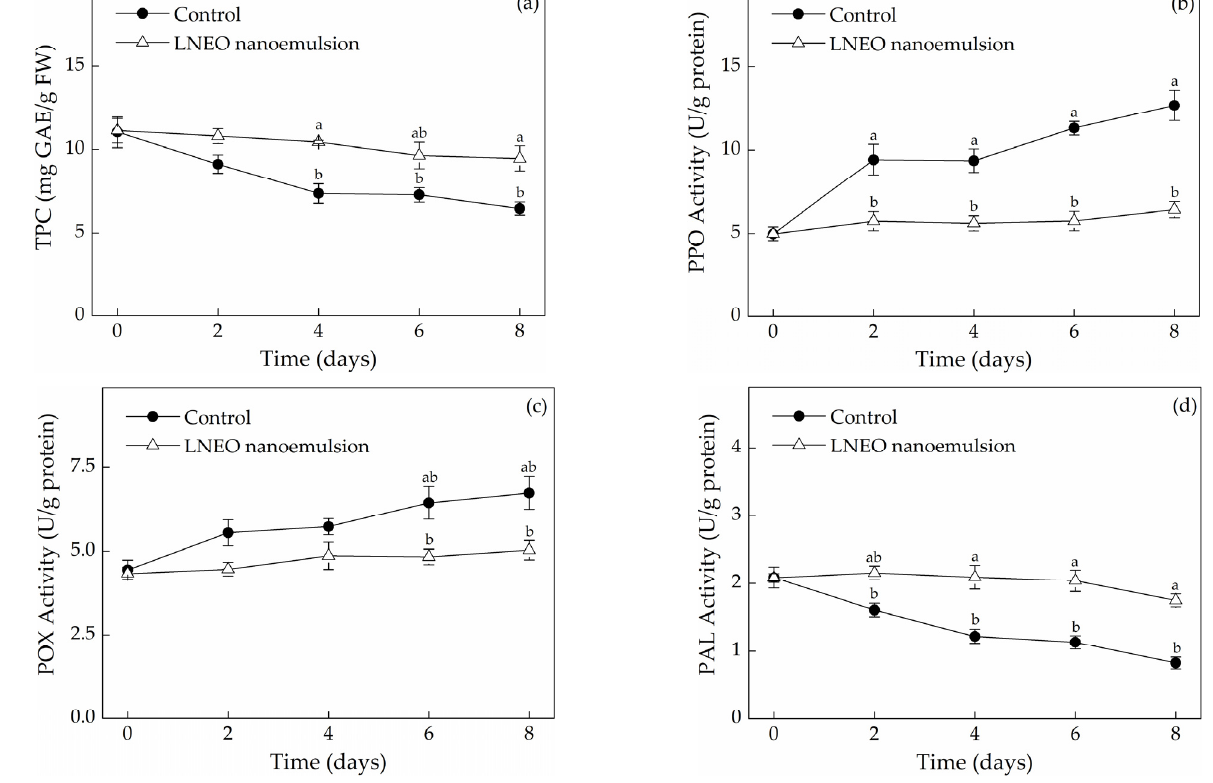
Figure 2. Effects of the LNEO nanoemulsion on TPC ( a ) and activities of PPO ( b ), POX ( c ) and PAL ( d ) in fresh-cut muskmelons. Data are the mean ± standard deviation (n = 3); a, b different letters denote statistical significance.